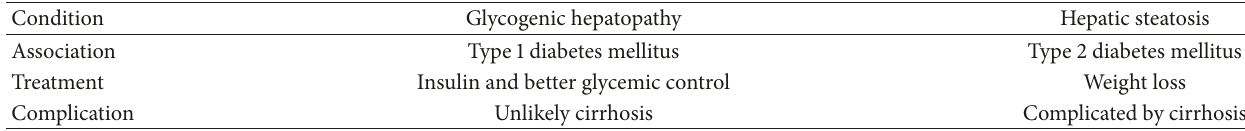
Figure 1: (a) Liver biopsy showing hepatocytic ballooning of moderate degree, with mild microvesicular and macrovesicular steatosis, and prominent glycogenated nuclei by PAS stain (magnification: × 40). (b) Hematoxylin and Eosin staining showing evidence of steatosis, nuclear glycogenosis, and lobular inflammation (magnification: × 100). Table 2: Glycogenic hepatopathy versus hepatic